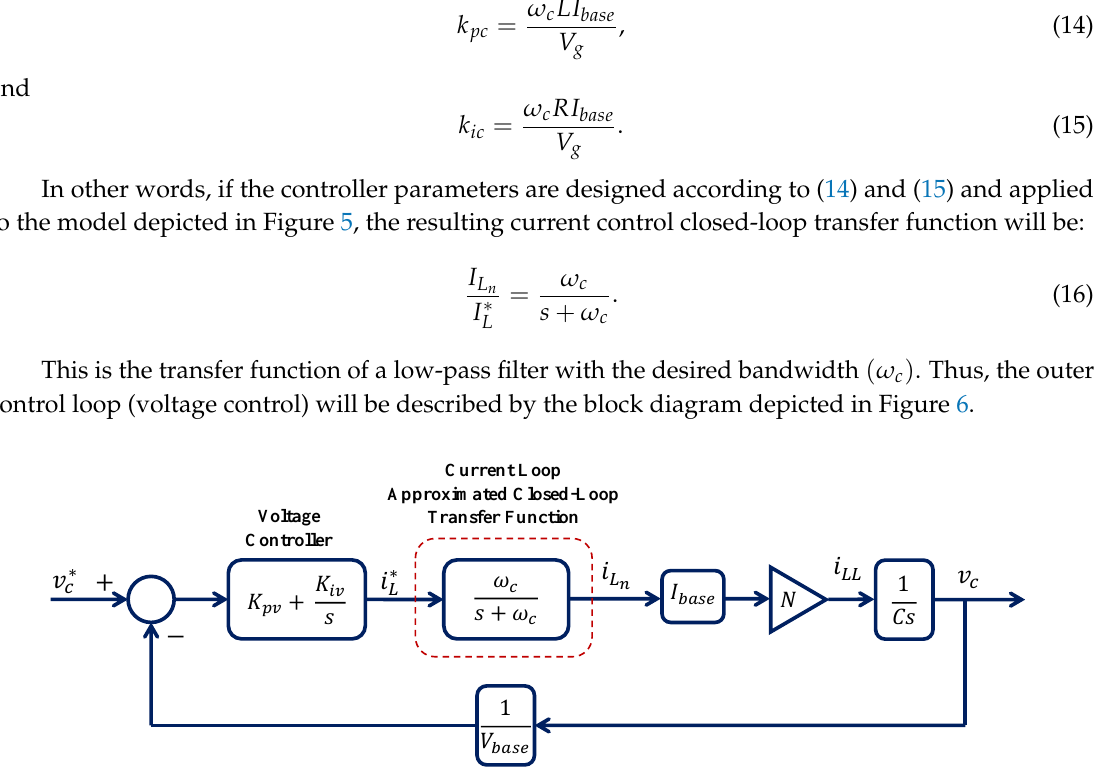
Figure 6. Voltage loop using the current loop approximated closed-loop transfer